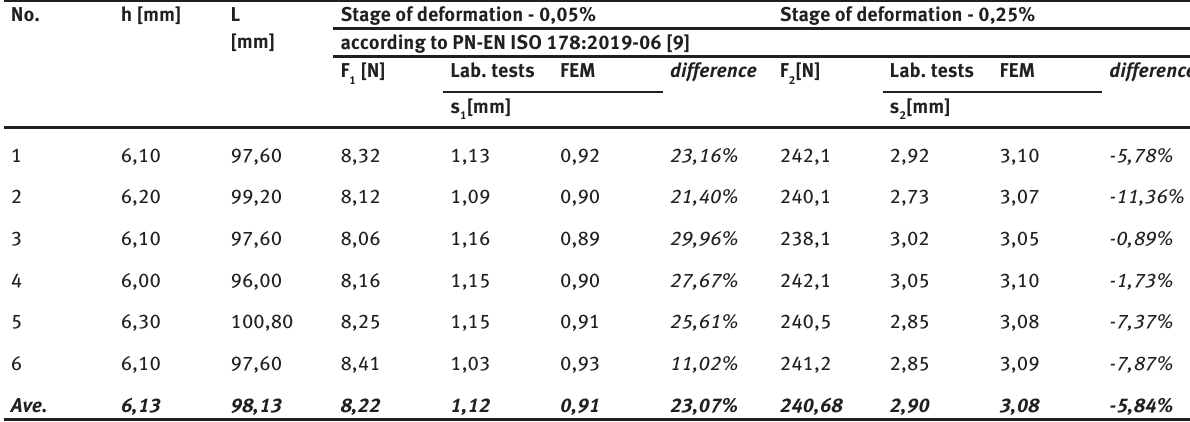
Table 5: Comparison of results of numerical analyses and laboratory tests for a model of a liner with a diameter of 200mm and 6,00mm wall thickness.